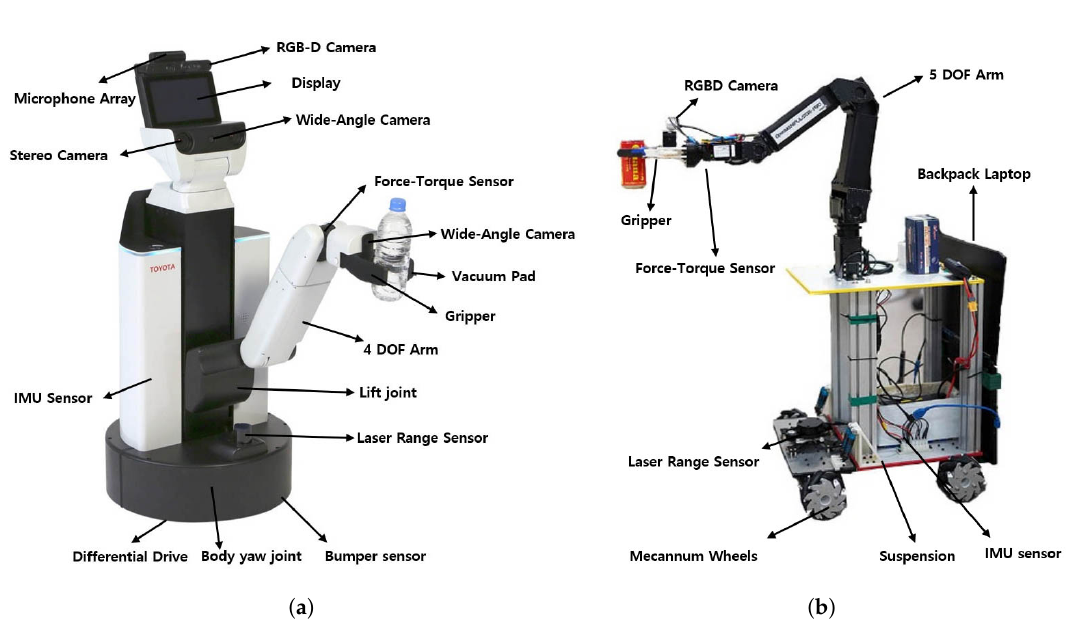
Figure 1. Two home service robot platforms used for this work. ( a ) Toyota HSR (Human Support Robot), ( b ) MSR-1 (Modular Service